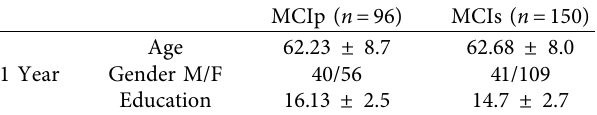
Table 2: Subjects demographics.